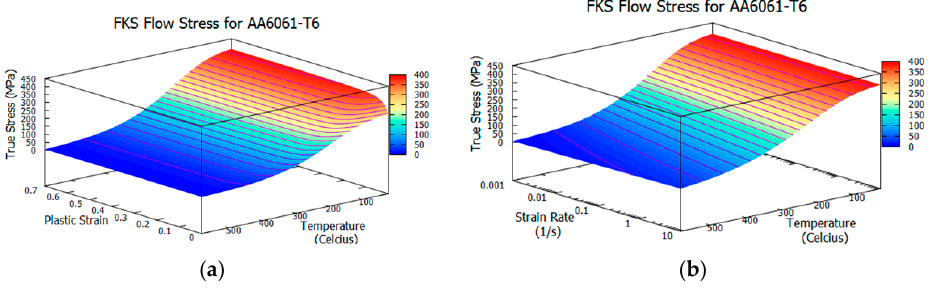
Figure 2. Fraser–Kiss–St-Georges (FKS) flow stress model for AA6061-T6: ( a ) as a function of plastic strain and temperature; and ( b ) as a function of strain rate and temperature. strain and temperature; and ( b ) as a function of strain rate and